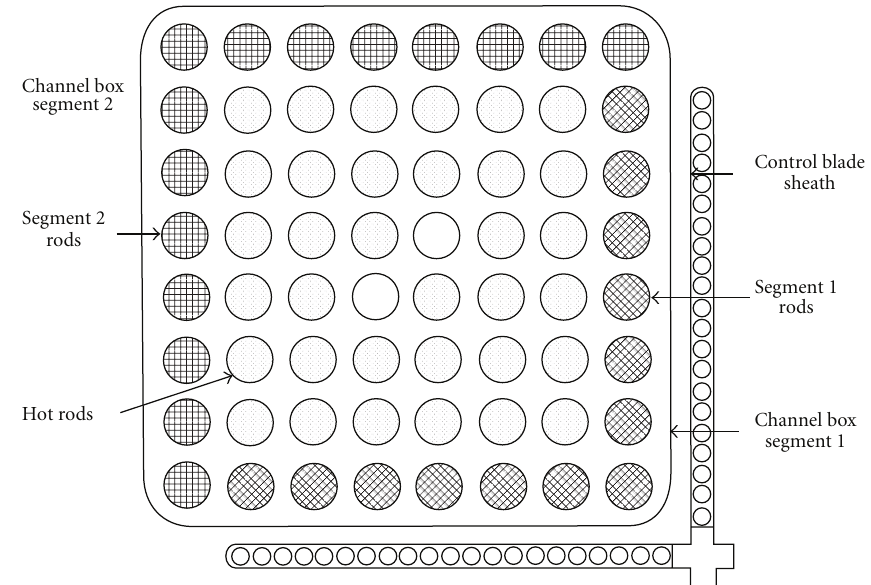
Figure 9: Representative RELAP/SCDAPSIM BWR assembly for Laguna Verde.